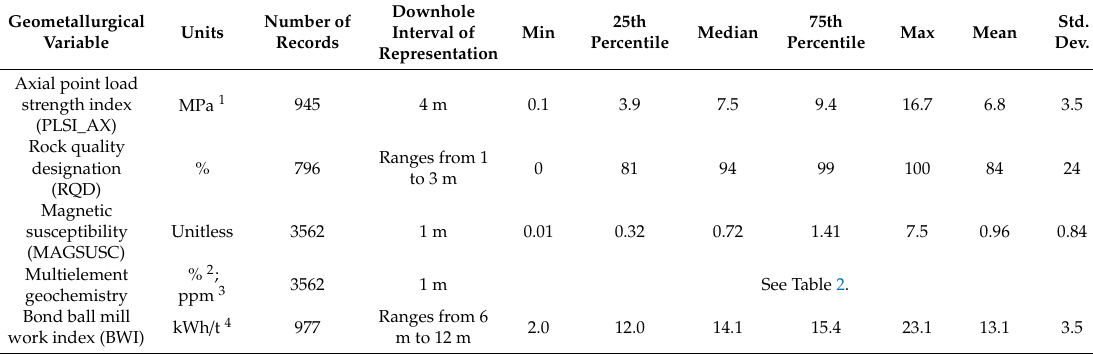
Table 1. Summary of the geometallurgical dataset in this study. Downhole interval of representation signifies the stepwise drillhole interval for which the variable was available in the Paracatu